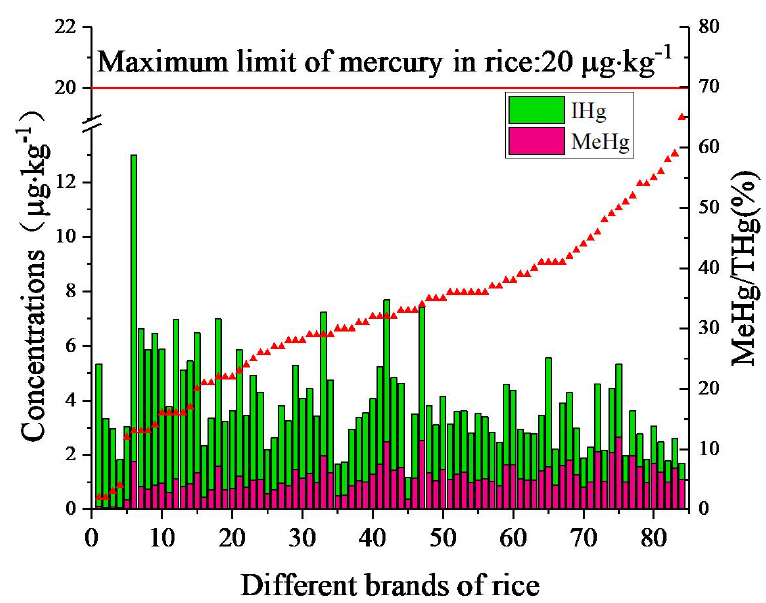
Figure 2. The THg and MeHg concentrations, %MeHg (of THg) of different brands rice.